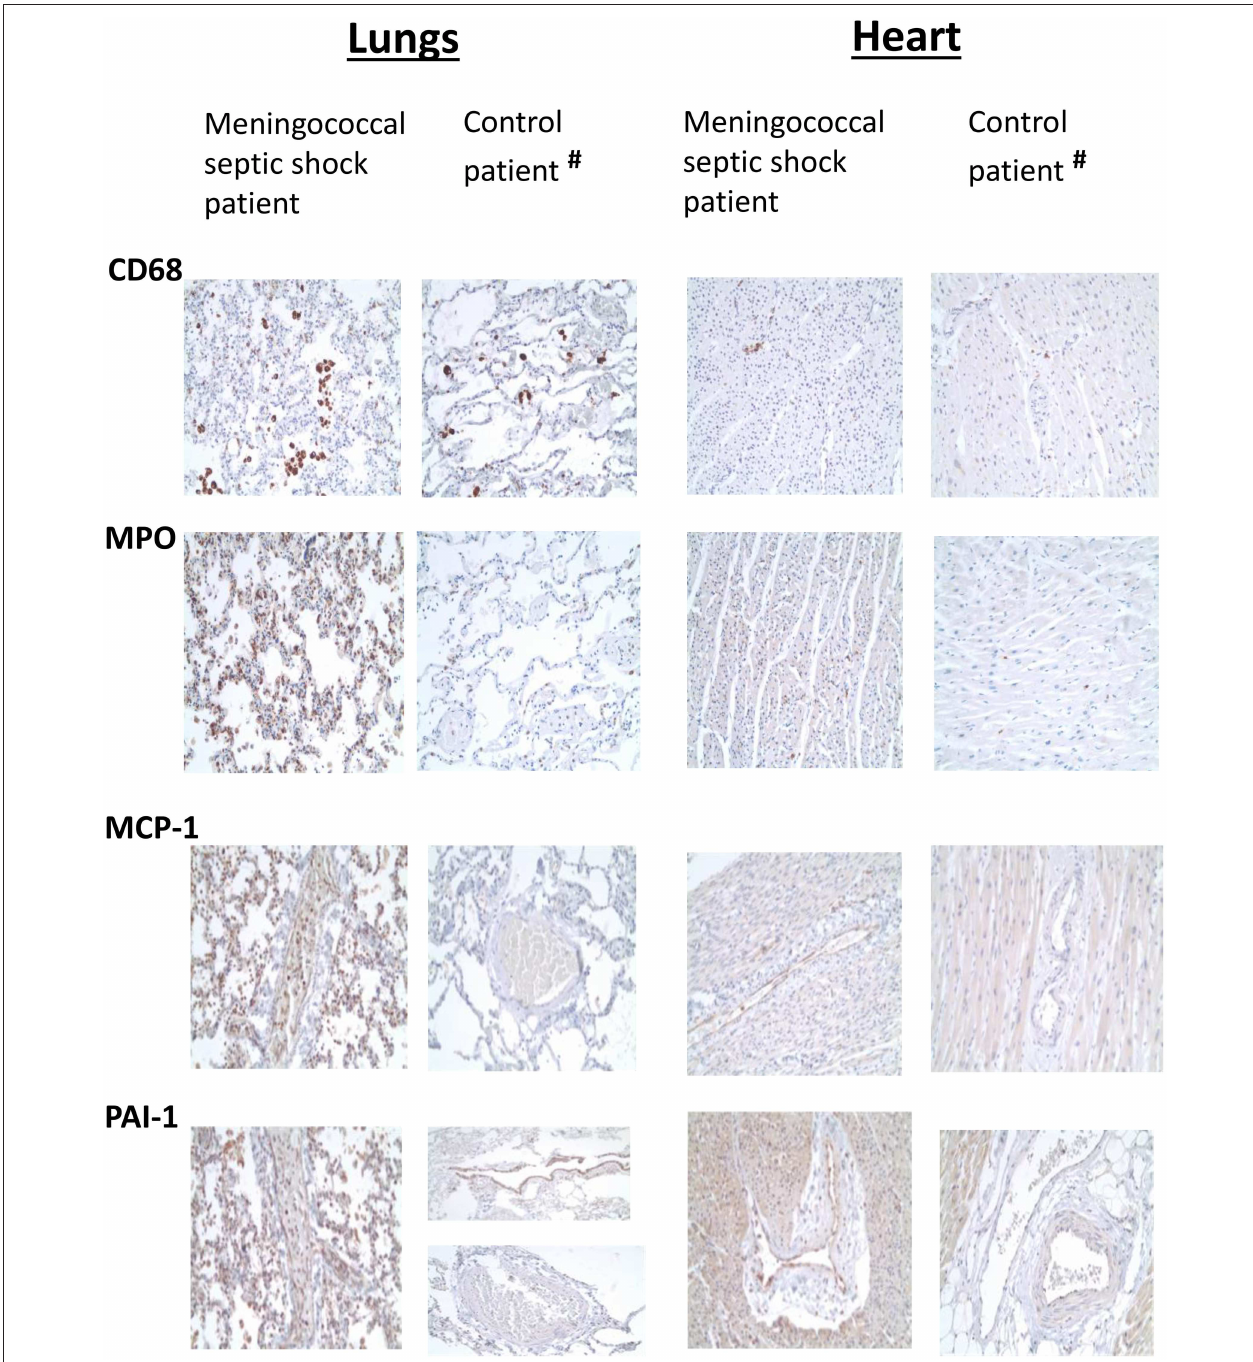
FIGURE 2 | Immunohistochemical examination of FFPE tissue samples (lungs and heart) from one meningococcal septic shock patient and one control (acute non-infectious death). Immunohistochemical detection of CD68, MPO, MCP-1, and PAI-1 positive cells (labeled brown) in sections from lungs and heart from meningococcal septic shock patient and control patient with acute non-infectious death (Obj. x20) ( # The control patient, elderly smoker).